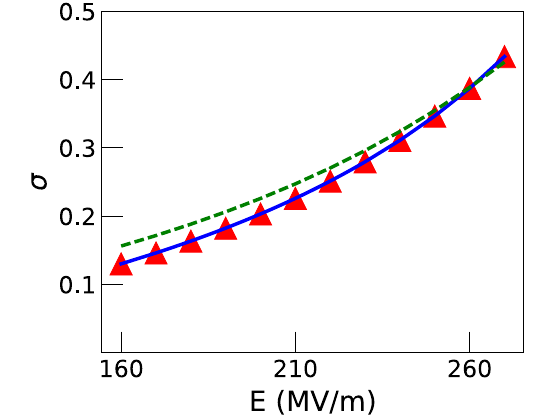
FIG. 18. Standard deviation of the QSD as a function of the electric field, calculated numerically from the QSD of the metastable approximation [Eq. (11), solid line], calculated by treating the QSD approximately as a Poisson distribution [Eq. (13), dashed line], and found from the simulation (triangles).